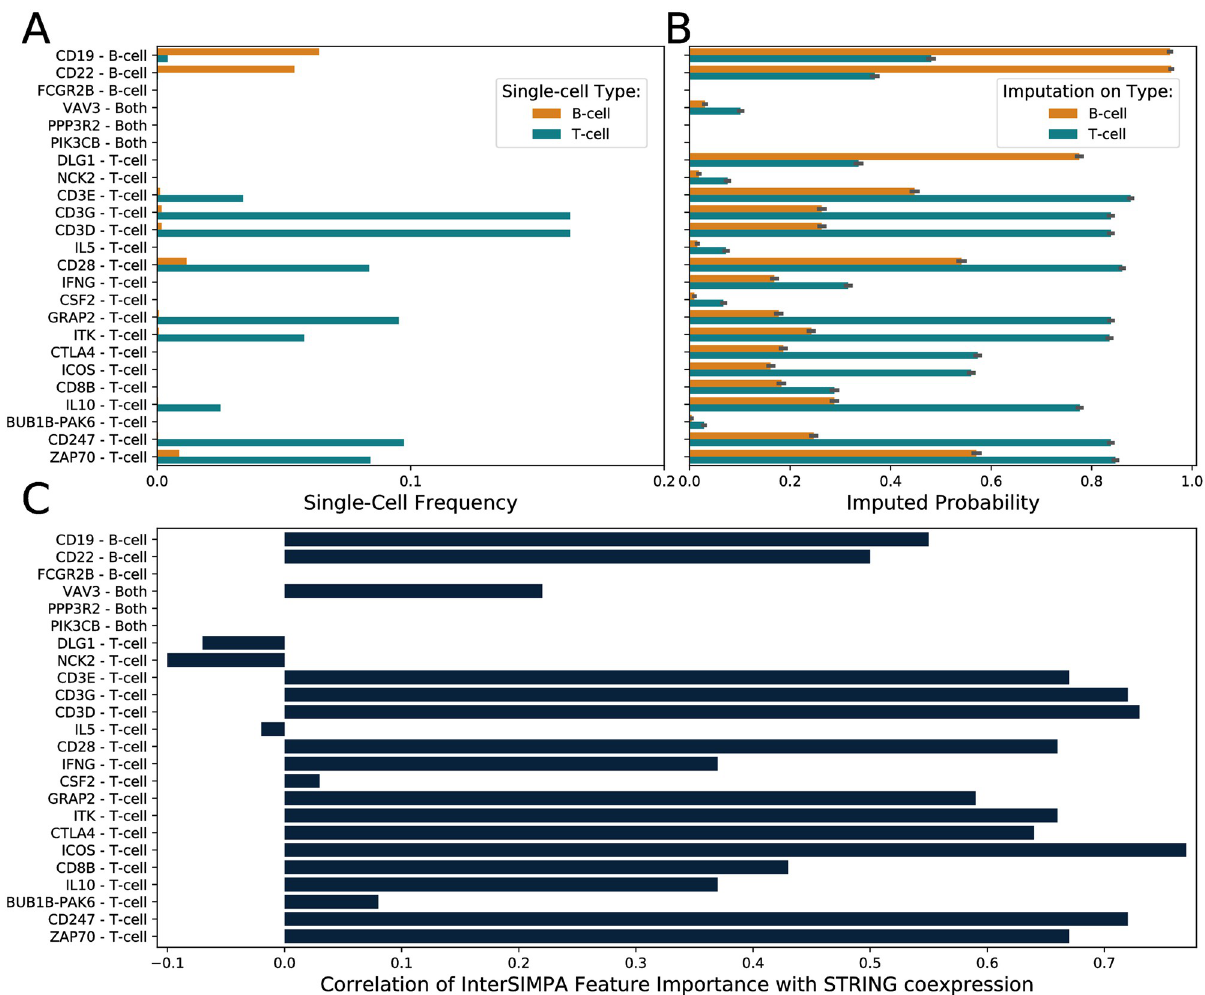
Fig 4. Pathway related gene analysis using the interpretation of imputation models. A . Fraction of single cells for which H3K4me3 binding is observed within the gene’s promoter region in the human single-cell dataset (orange and blue bars representing B-cells or T-cells, respectively). Y-axis labels show the gene names and if the gene belongs to the B-cell or T-cell receptor signaling pathway or to both. B . Imputed probability computed by SIMPA for the gene-related promoter regions shown in A. The imputation was applied on numerous single cells from the cell-types B-cell (orange) and T-cell (blue). The error bars represent the standard deviation across the imputation runs on different cells. For the majority of genes, the imputed probability is higher within the cell-type that corresponds to the gene’s pathway. C . Correlation of feature importance and co-expression values. For each model used to impute a promoter (y-axis), the training features (genomic bins) were extracted together with their importance value provided by the Random Forest algorithm and annotated with the nearest gene on the genome. Co-expression values, derived from transcriptomic and proteomic measurements, of those genes with the gene related to the imputed promoter were retrieved from the STRING database. The Pearson correlation coefficient of feature importance and co-expression values is shown (x-axis).